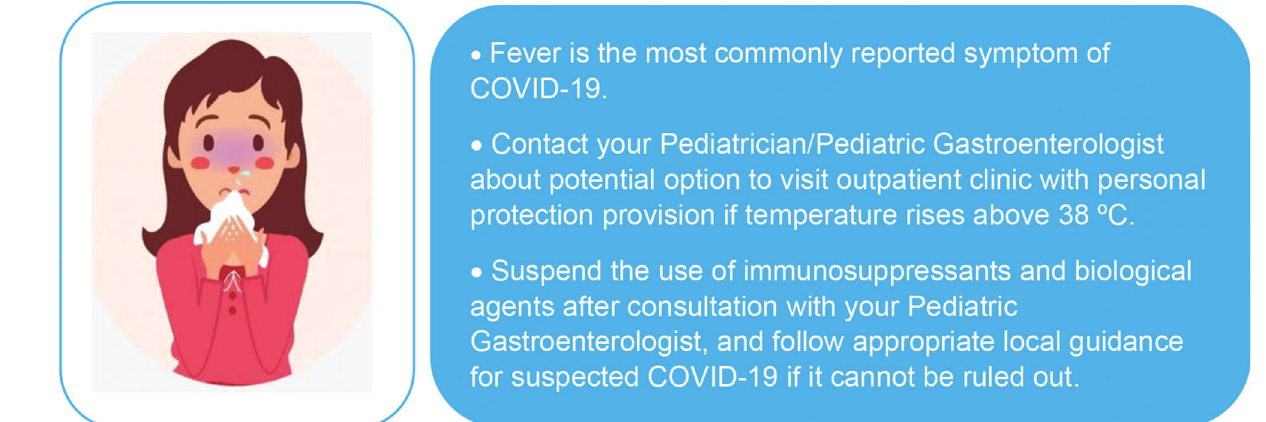
Figure 3 - Recommendations for pediatric IBD patients with fever during the COVID-19 pandemic. Modified by Mao et al. (29).